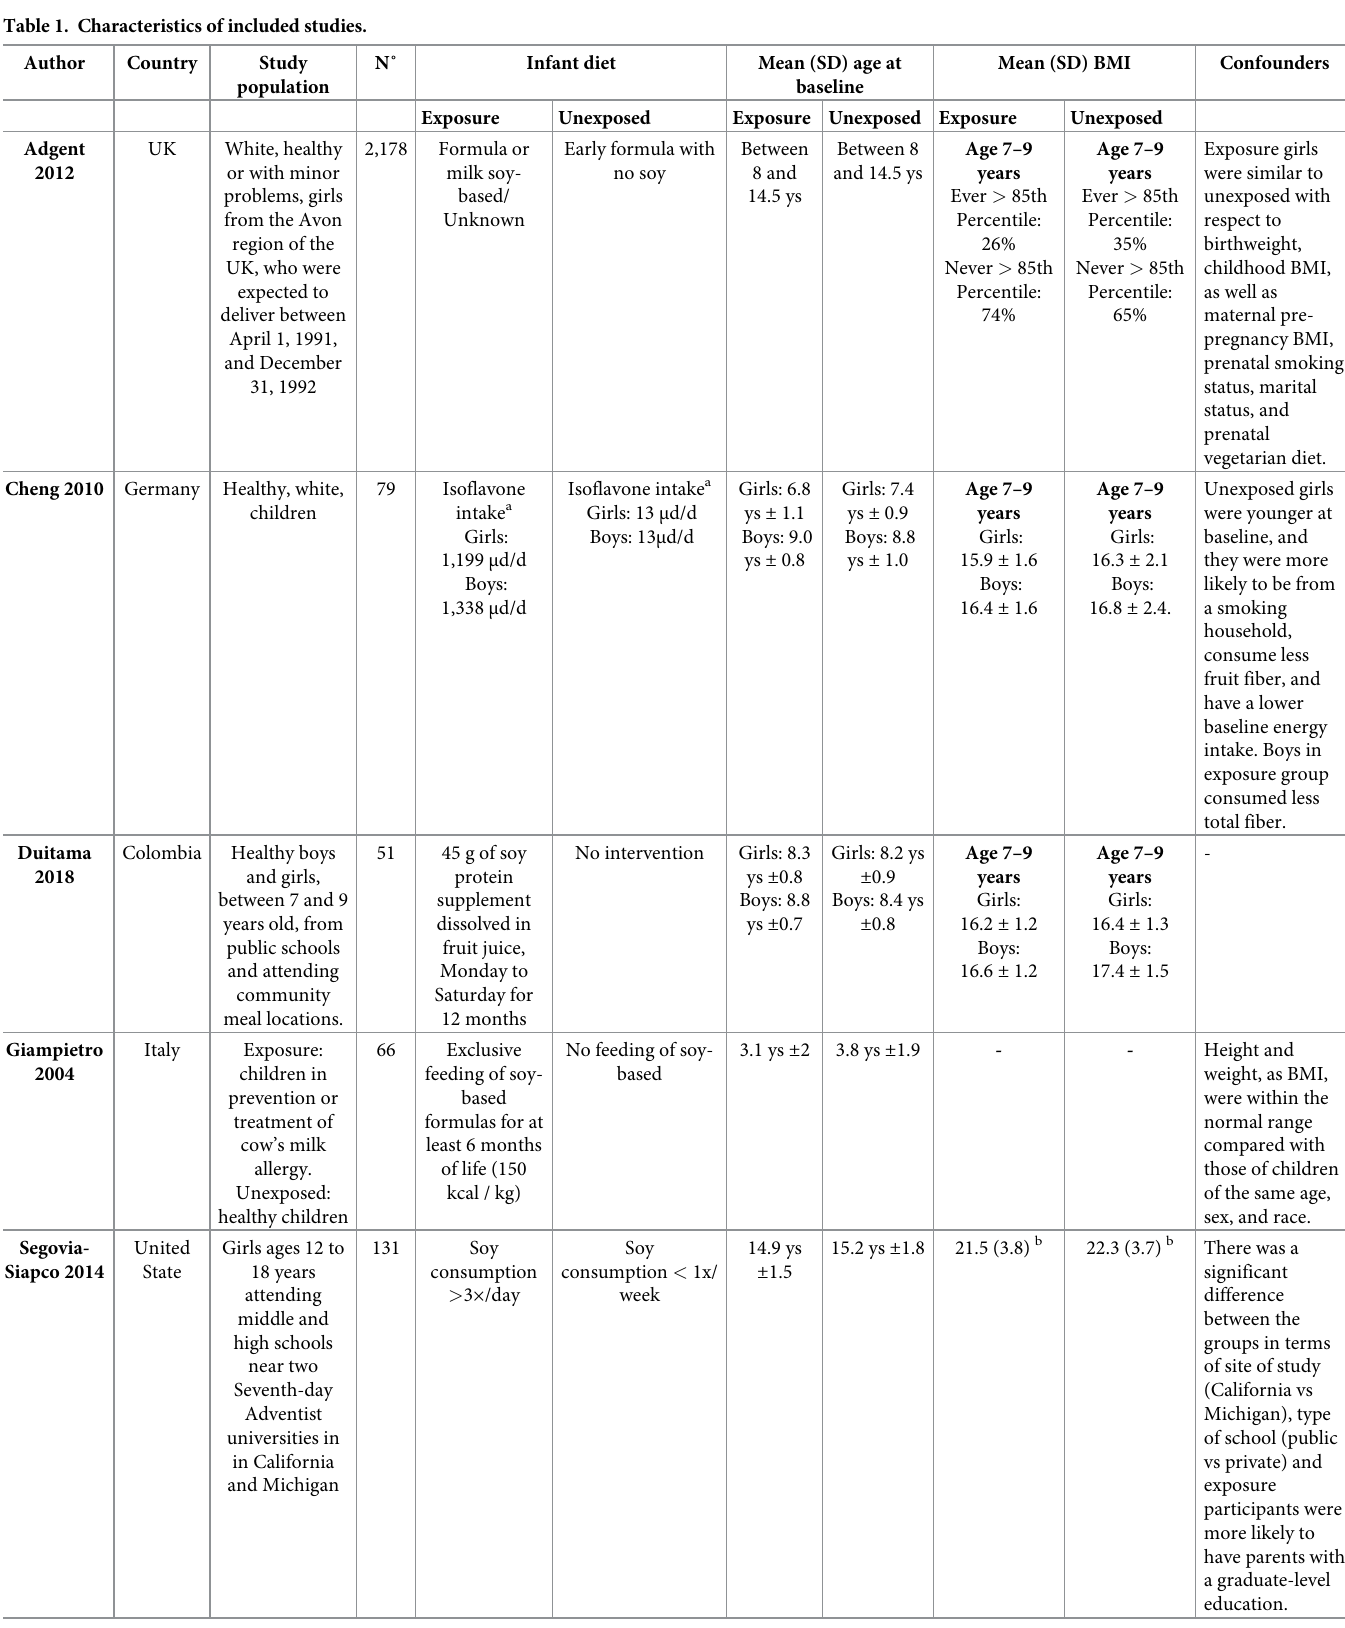
Table 1. Characteristics of included